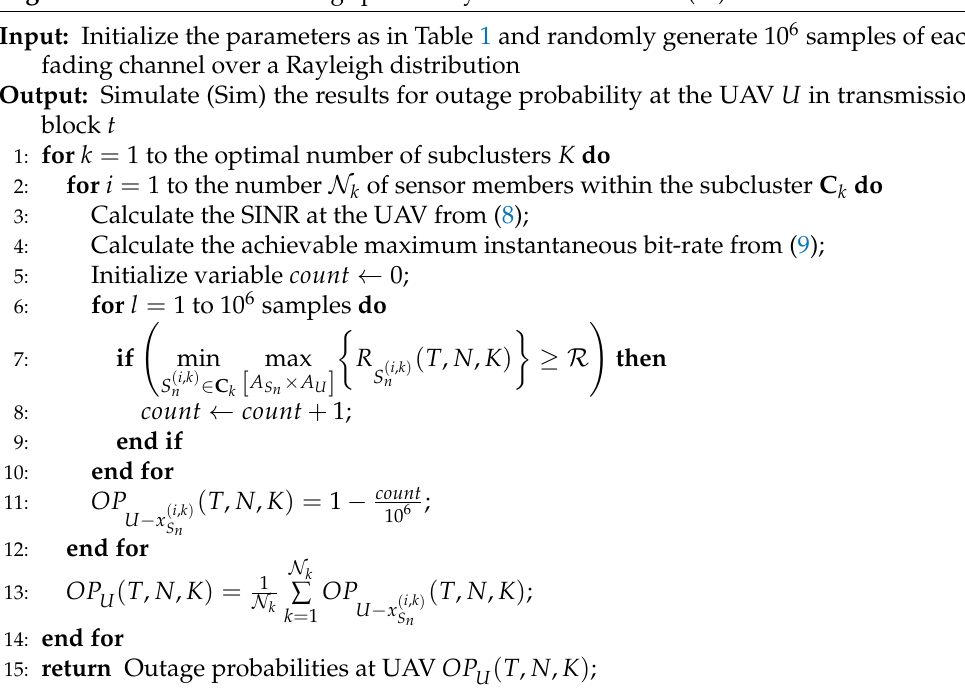
Algorithm 2 Calculate the outage probability at the UAV U from (16) for transmission block t